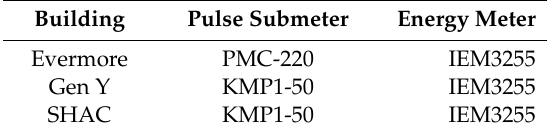
Table 2. Meters utilized in shared energy microgrid